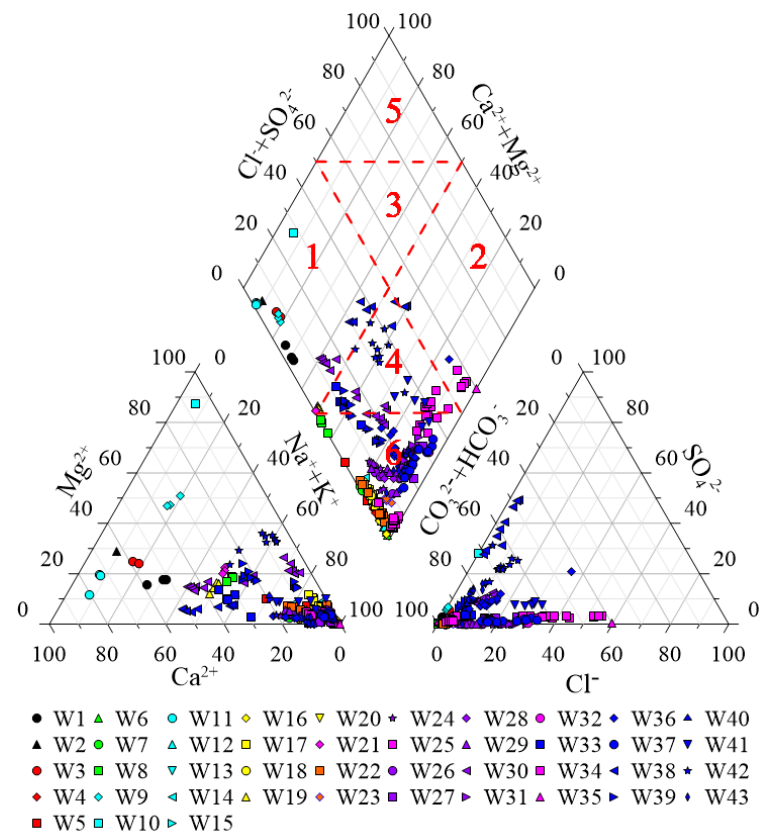
Figure 3. Piper diagram showing major ion chemistry of the sampled points.